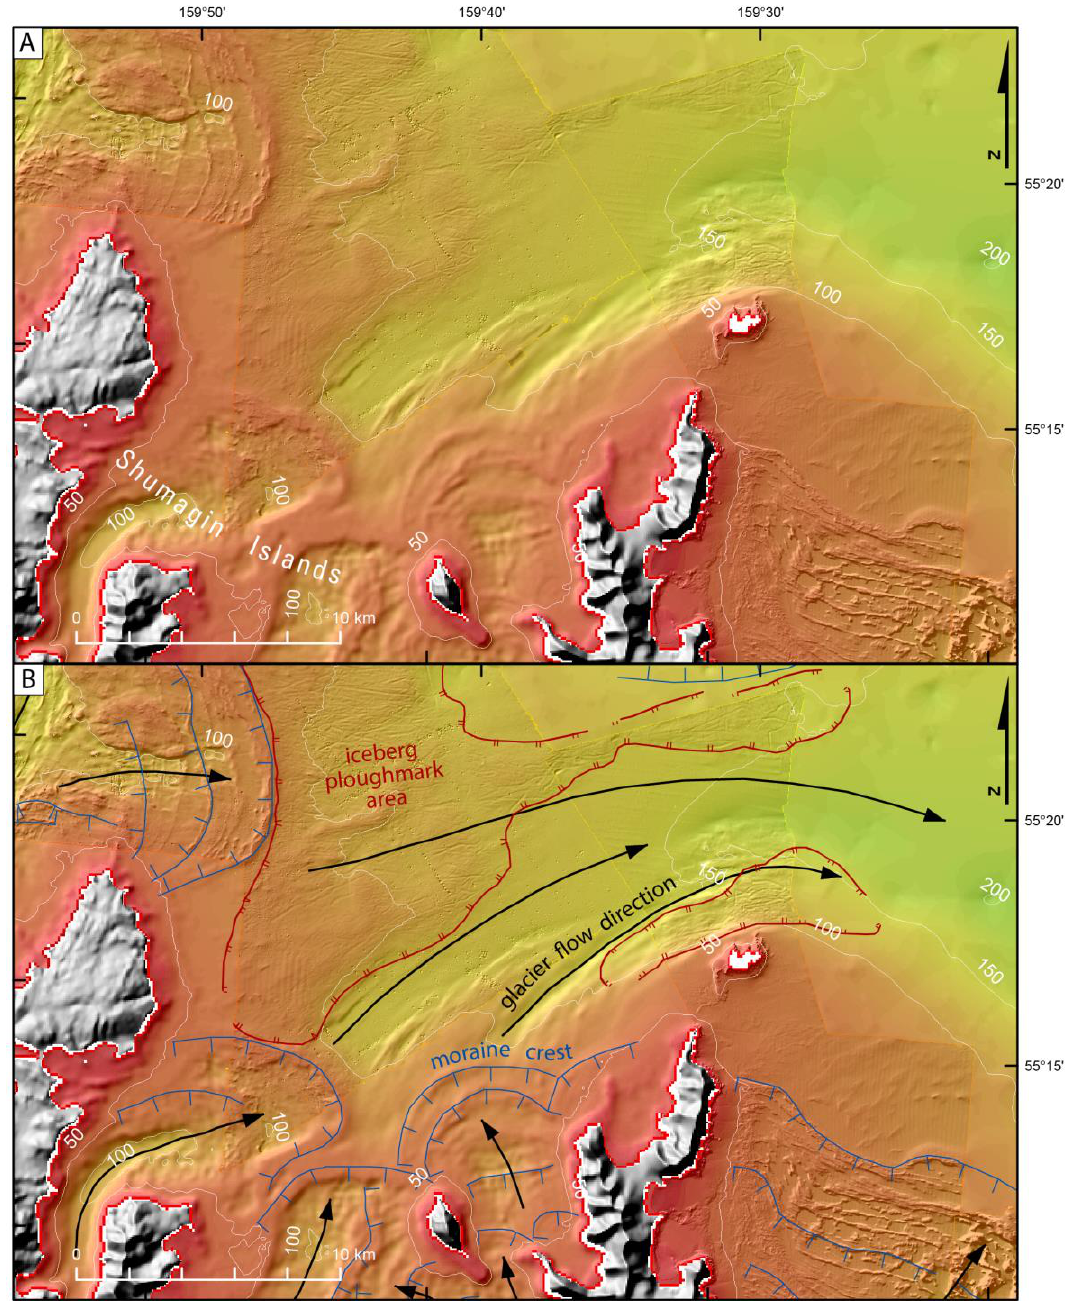
Figure 11. Glacial features on the north side of the Shumagin Islands. ( A ) uninterpreted, ( B ) interpreted. Location of map is shown on Figure 5 and the symbology is the same as Figure 5. This region is notable for having abundant parallel recessional moraines, in the bottom right part of the map, and the glacial lineations distal to the prominent moraines. At the top, there are iceberg ploughmarks adjacent to the prominent moraine crest, and the dominant ploughmark direction is away from the moraine crest, all of which suggests that the glacier was a tidewater glacier.